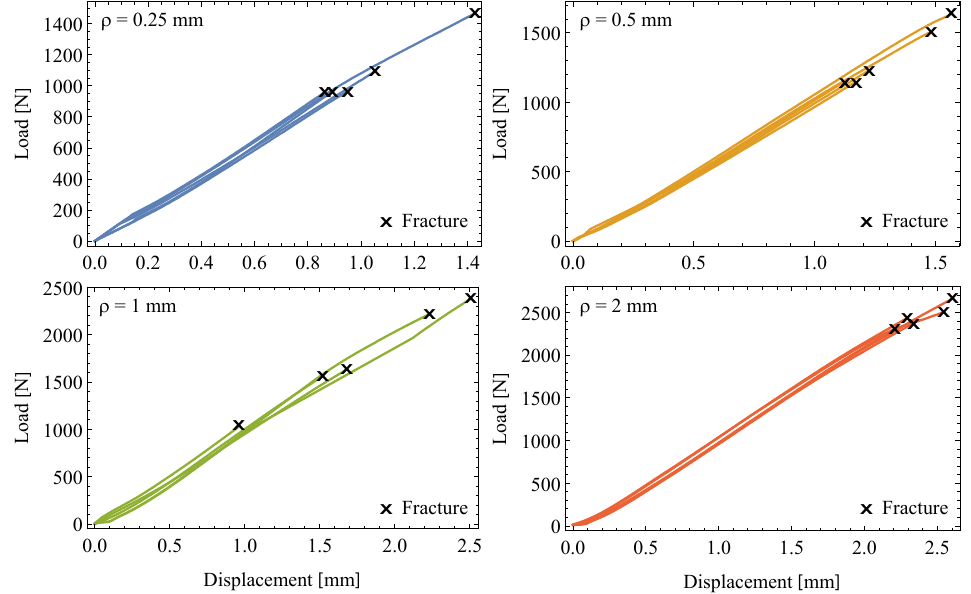
Figure 4. Experimental load-displacement plots for the different samples of EPOLAM 2025 with notch radii, ρ = 0.25,05,1 and 2 mm.